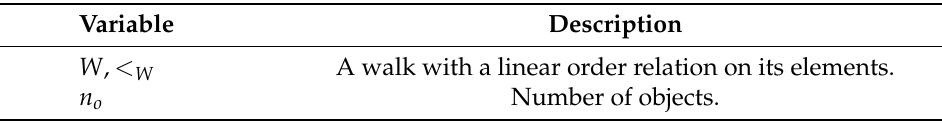
Table 10. Input data for the Phase 2 algorithm.